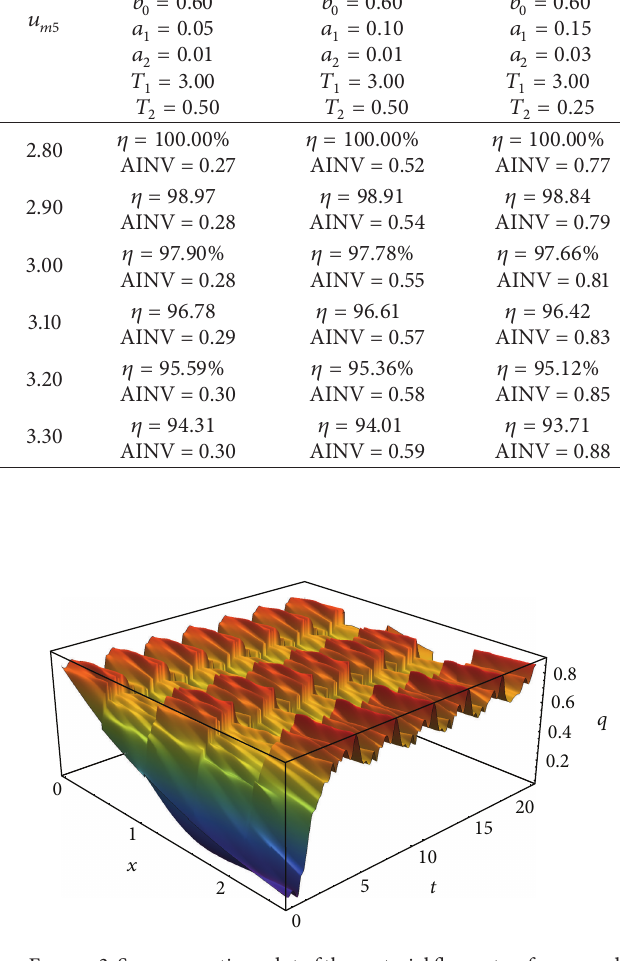
Figure3:Space-overtimeplotofthematerialflowrate 𝑞 fromgoods receiving (𝑥 = 0) to dispatch area (𝑥 = 2.5)